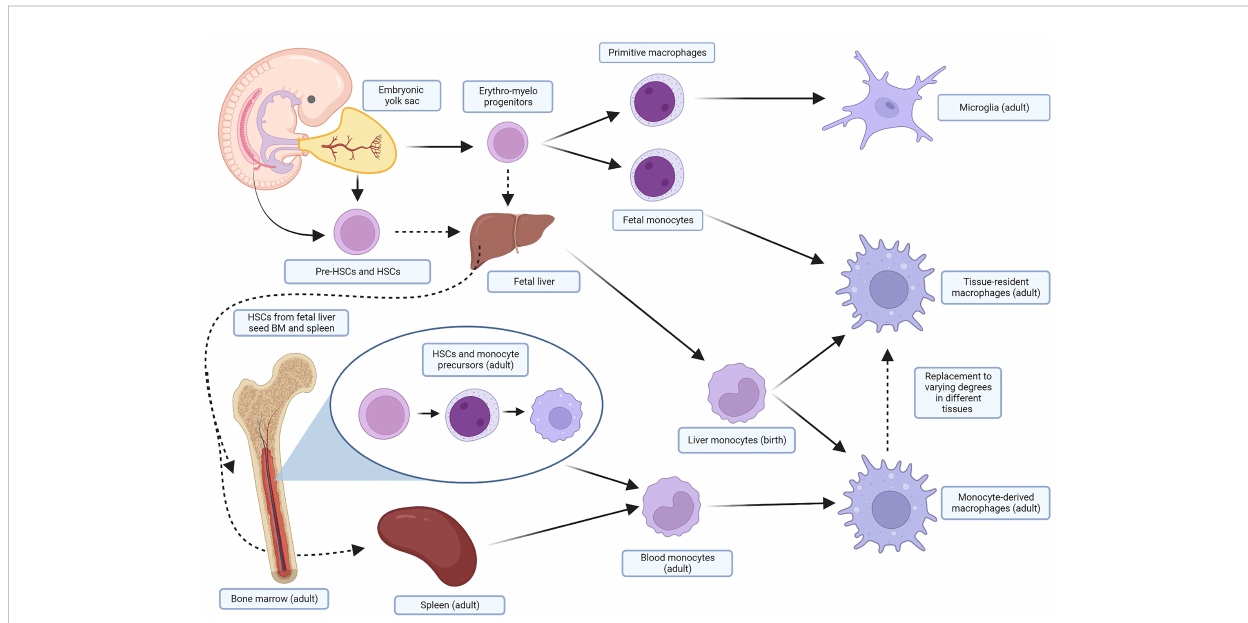
FIGURE 1 Simpli fi ed ontogeny of macrophages. In several waves of primitive hematopoiesis stemming initially from the embryonic yolk sac, erythro-myeloid progenitors differentiate into primitive macrophages and fetal monocytes that eventually become adult microglia and TRMs, respectively. These progenitors also seed the fetal liver, along with pre-HSCs and HSCs from the embryo, yolk sac, and placenta. The fetal liver, the major site of hematopoiesis, subsequently produces liver monocytes, which likely contribute perinatally to macrophage pools in the adult. HSCs, after maturing in the fetal liver, also seed the fetal bone marrow and spleen. In the adult, HSCs from the bone marrow differentiate through several monocyte precursors before being released into the blood as monocytes. These cells are recruited by in fl ammation and injury in the tissue, and terminally differentiate into MDMS. The spleen also holds a pool of monocytes that can be mobilized when needed. TRMs will be replaced to varying degrees in different tissues by MDMs in the adult. Many of these steps are areas of ongoing research and debate in murine and human models; similar